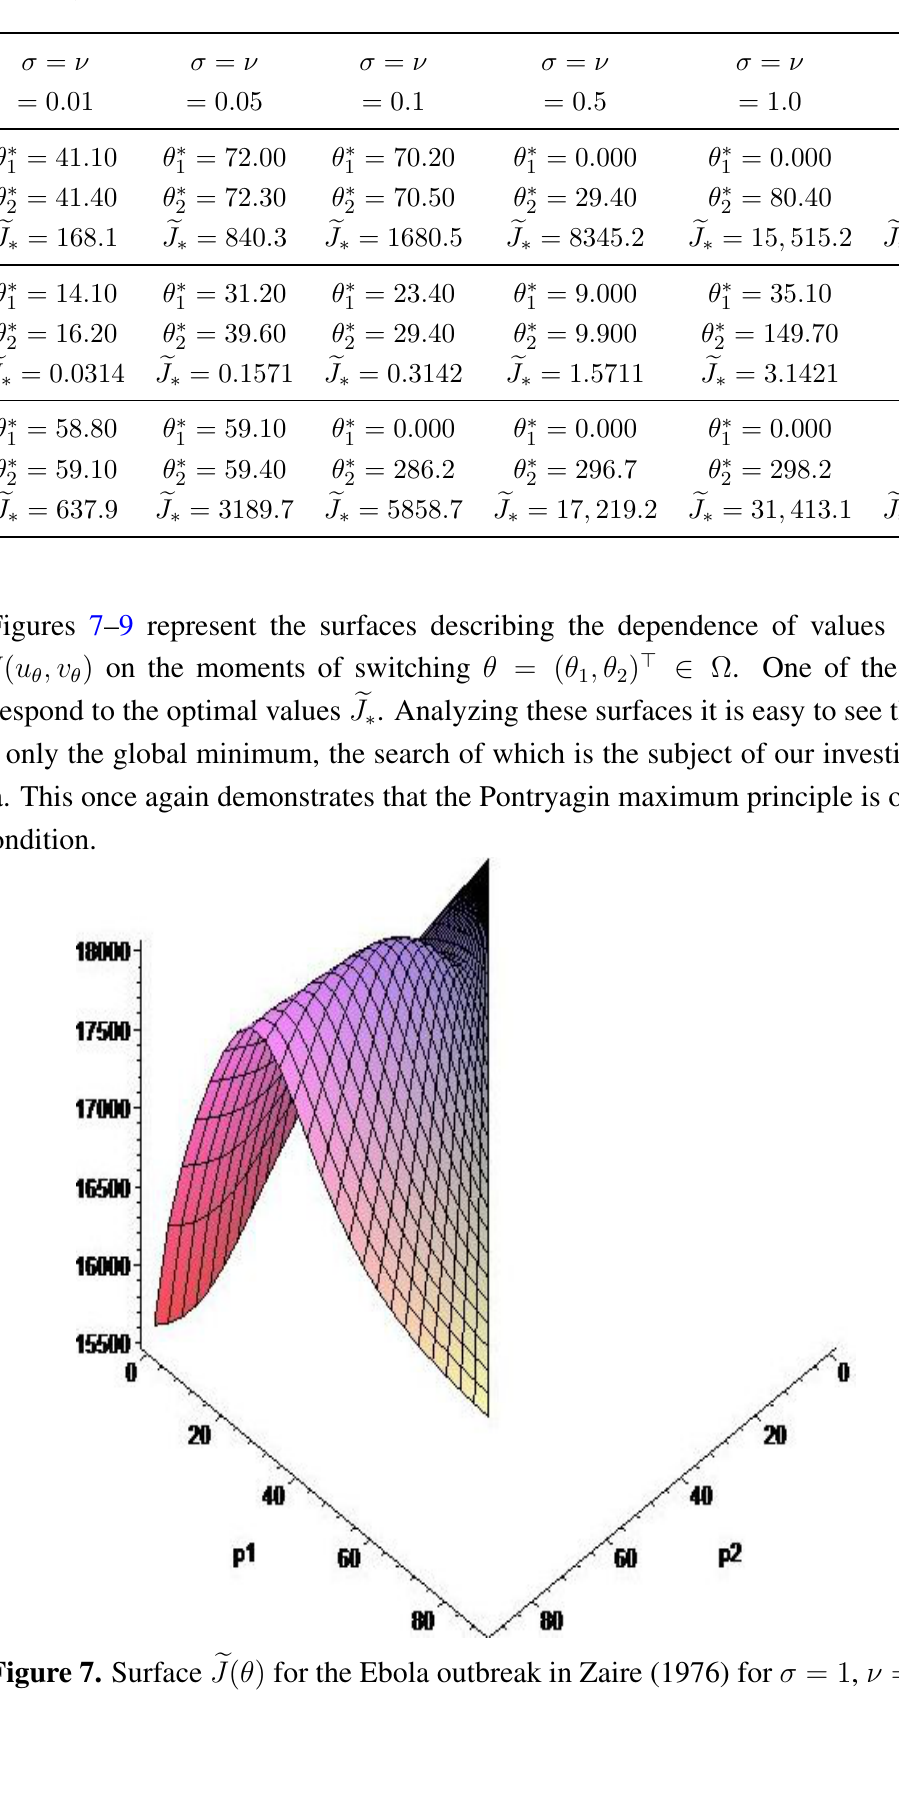
and the optimal value (cid:101) J , θ ∗ 2 1